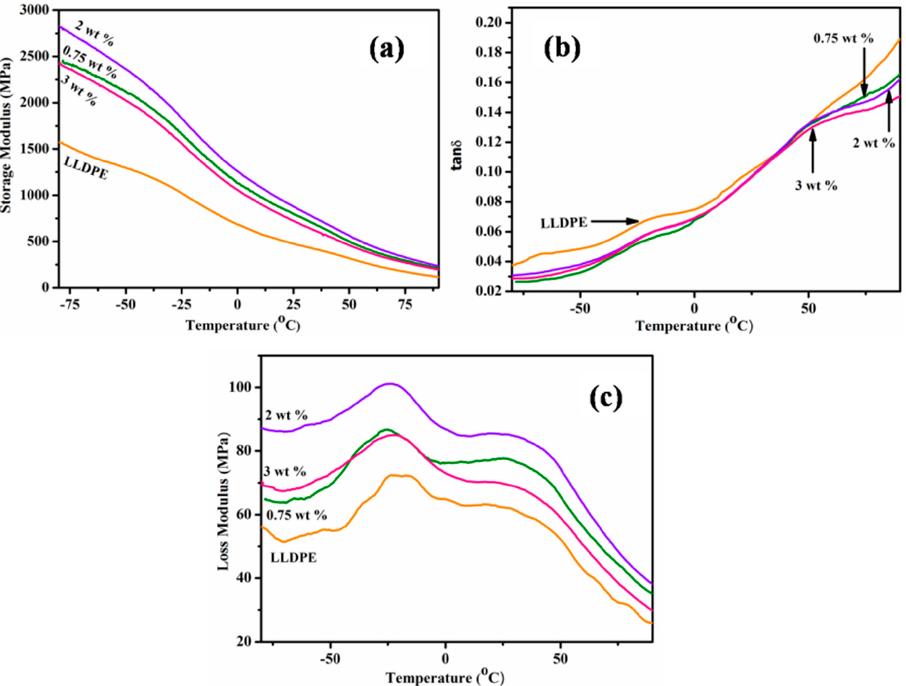
Figure 8. Variation of storage modulus (E’) with temperature ( a ), variation of tan δ with temperature ( b ), and variation of loss modulus (E”) with temperature for CTAB–MoS 2 /LLDPE composites ( c ).